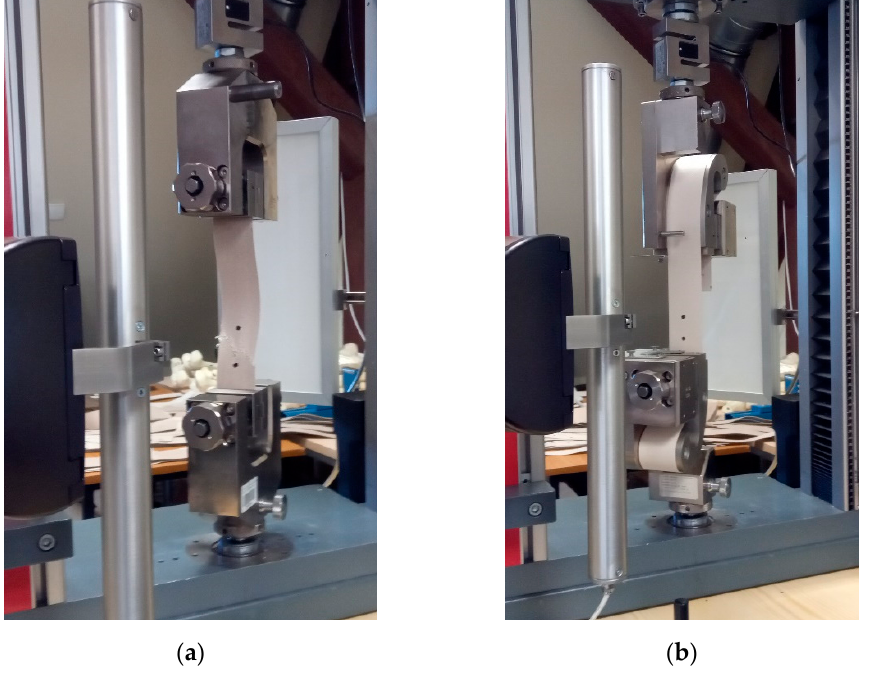
Figure 2. Uniaxial laboratory tests stand. Coated fabric samples fixed: ( a ) in flat grips; ( b ) in curved grips.